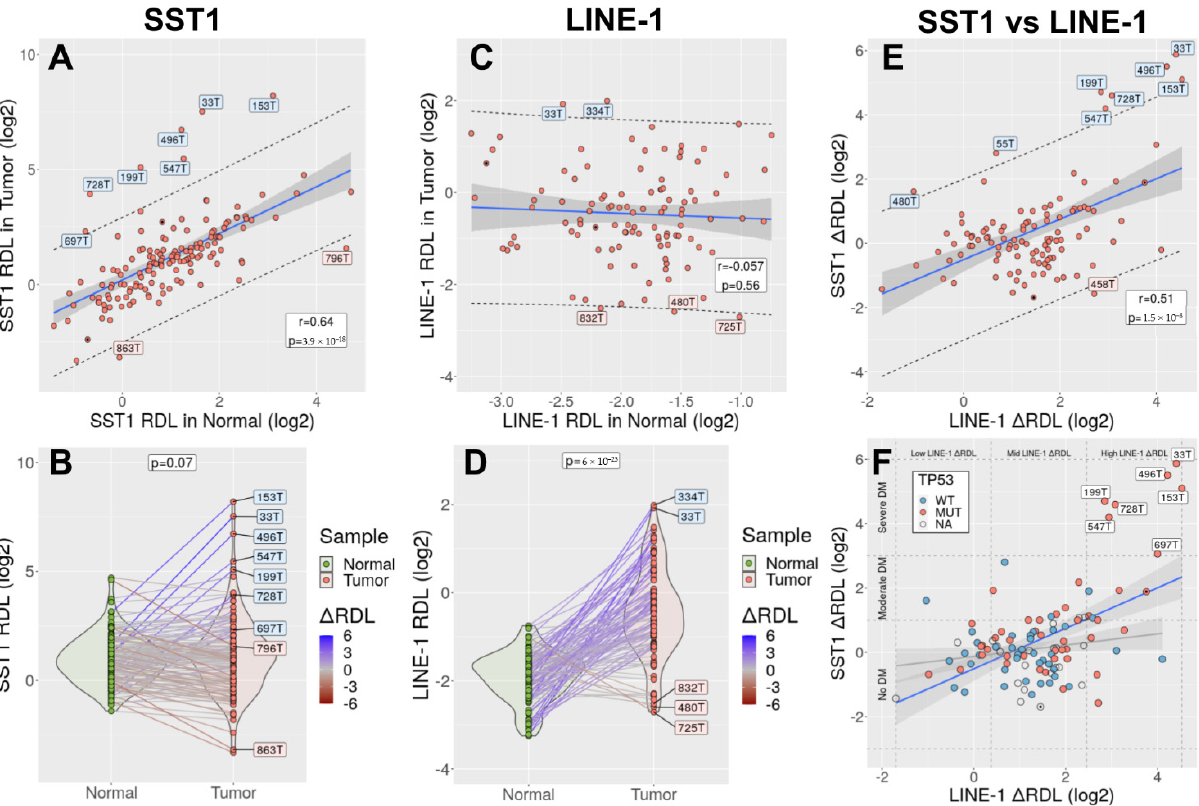
Figure 4. ( A ) Correlation between SST1 RDL in 148 CRC tumors ( y -axis) and matched normal tissues ( x -axis). Every dot represents a tumor. In blue, the regression line. Shaded in grey, the 95% CI of the slope. The dashed lines indicate the 95% CI of the values predicted by the regression model. Labeled in blue and red, tumors with SST1 RDL above (strongly demethylated) and below the predicted upper limit of the 95% CI, respectively. Two metastases are indicated with an internal black dot. ( B ) SST1 RDL values in normal tissues (green) and tumors (red). Tumor and matched normal samples are connected by solid lines, colored according to their difference in SST1 RDL (somatic demethylation, Δ RDL). Tumors with SST1 RDL values outside the 95% CI of the regression model prediction (shown in panel A) are labeled. ( C ) Correlation between LINE-1 RDL in 107 tumors and matched normal tissues. Symbols as in panel A. ( D ) LINE-1 RDL values in normal tissues and tumors. Symbols as in panel B. ( E ) Correlation between SST1 Δ RDL and LINE-1 Δ RDL. Symbols as in panels A and C. ( F ) Correlation between LINE-1 and SST1 somatic demethylation in 107 CRCs. Tumors are colored according to their TP53 mutational status (WT: wild type; MUT: mutant; NA: not analyzed). The graph is divided with dashed lines in nine areas according to the levels of LINE-1 ∆ RDL (horizontal axis, divided in low, mid and high demethylated) and SST1 ∆ RDL (vertical axis, divided into no demethylated, moderately demethylated and strongly demethylated). Two regression models are depicted, one with all the samples (blue line) and the other excluding the SST1 strongly demethylated cases (grey line). The dark grey areas indicate the 95% CI of the slope.